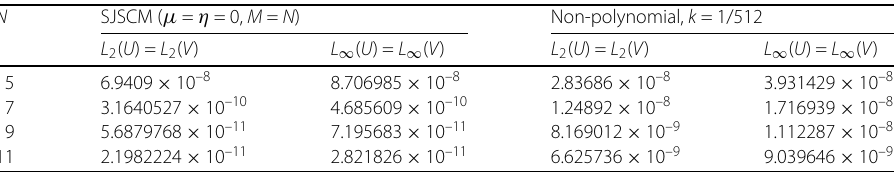
Table 7 L 2 and L ∞ error norms for u ( x , t ) = v ( x , t ) of Example 2 when 0 ≤ x ≤ 1, α 1 = α 2 = 0.01